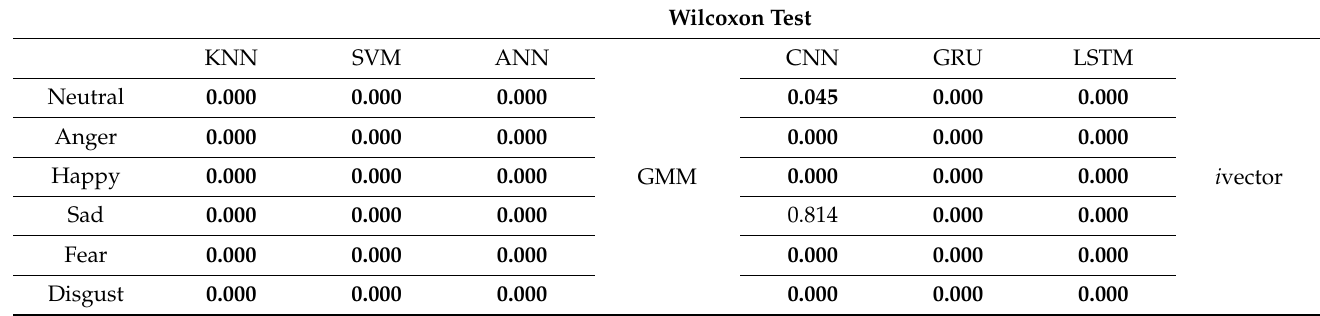
Table 5. p -value using Wilcoxon test for classical and deep models using the CREMA database.